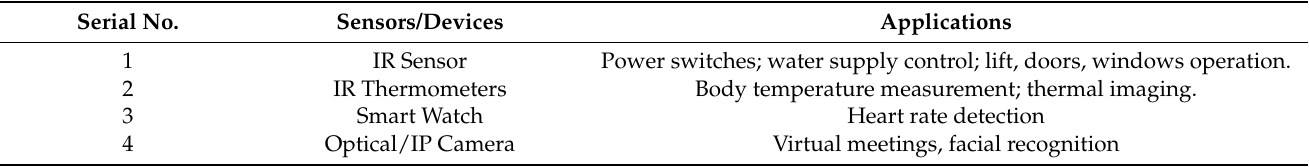
Table 5. Sensors/devices and